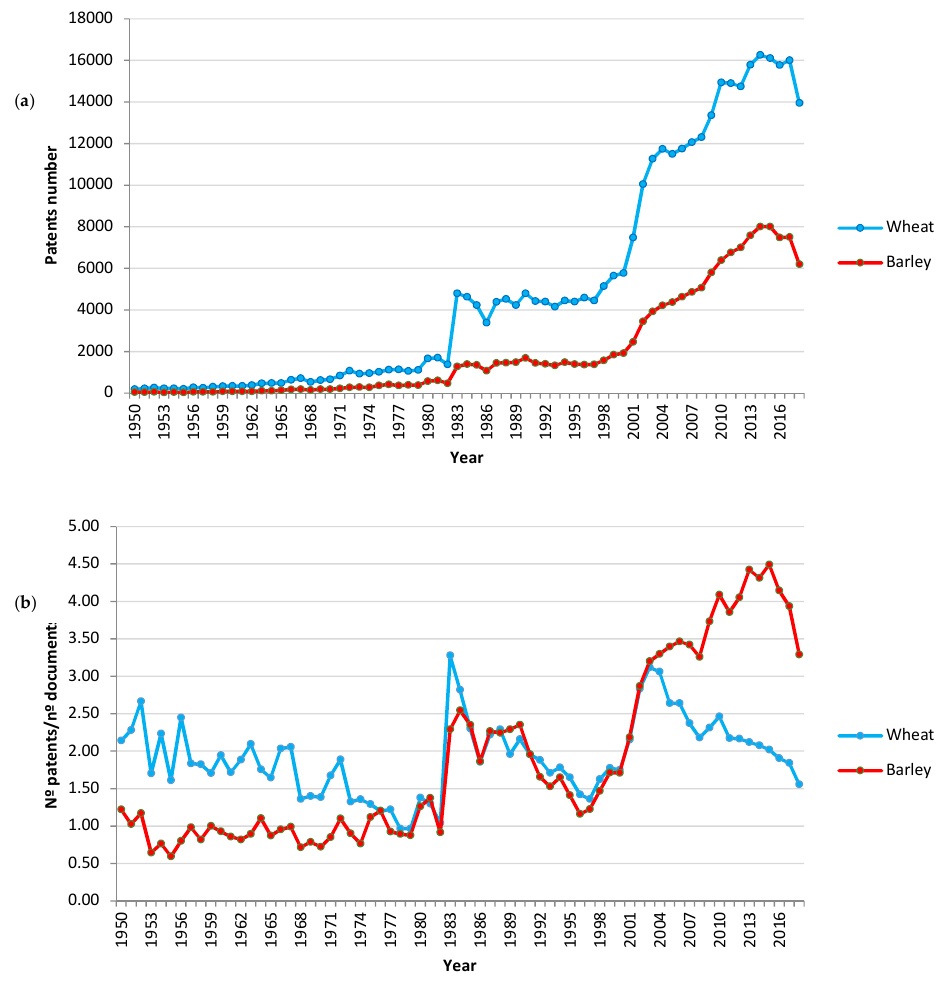
Figure 10. Trends in patents in the wheat and barley research fields. ( a ) Number of patents by year. ( b ) Ratio between patents and scientific documents.